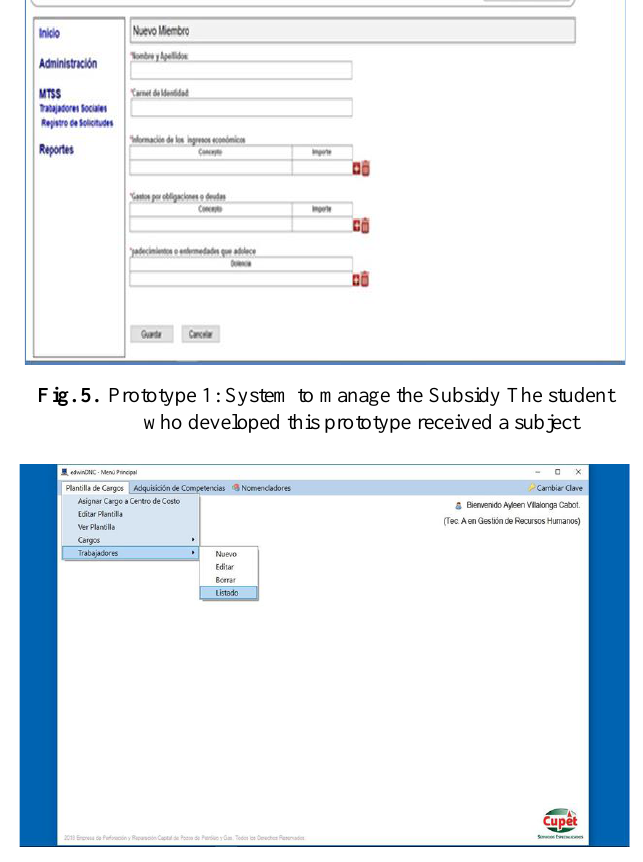
Fig. 6. Prototype 2 EMERCAP: Computer system for training management in